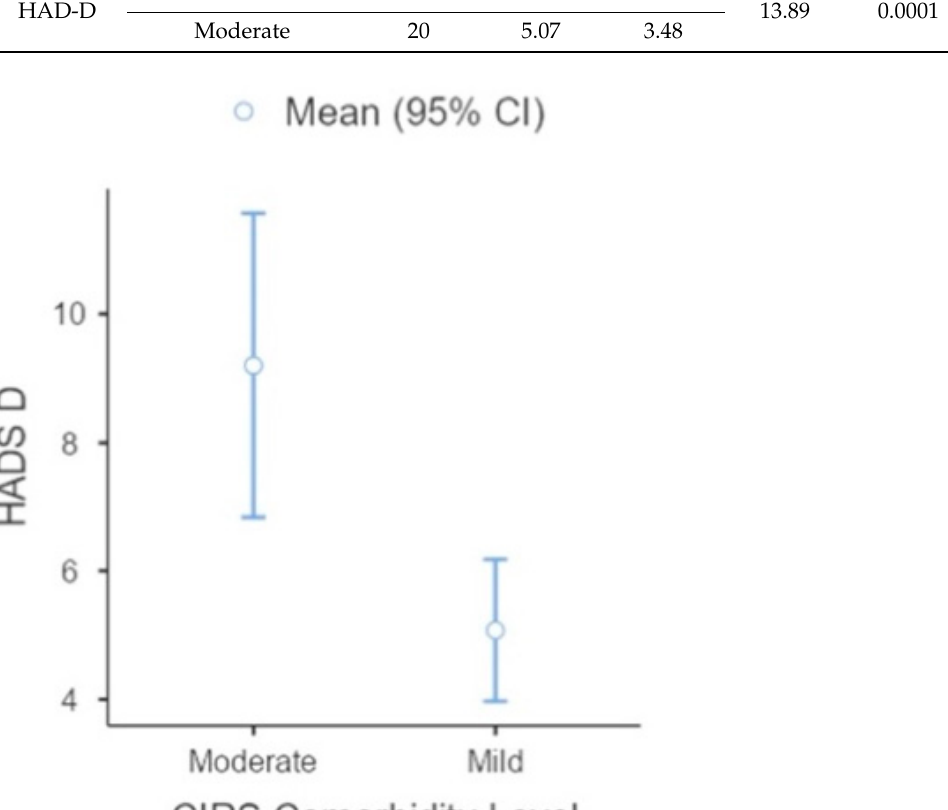
Table 4. One-way ANOVA on Depression data by CIRS indexes.